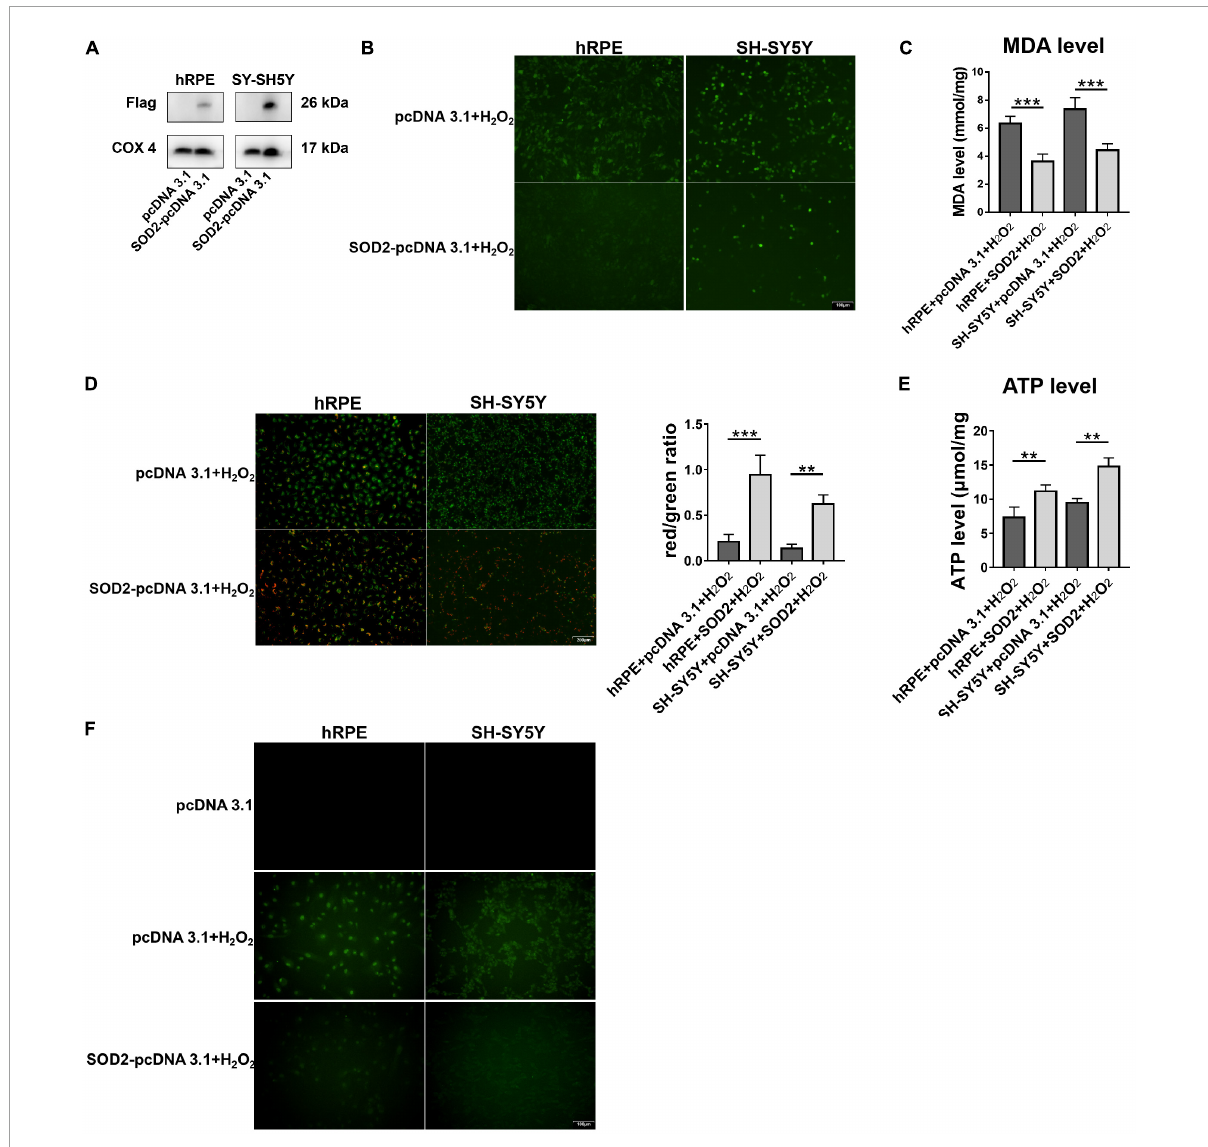
FIGURE5 Protective effects of SOD2 on hydrogen peroxide-induced oxidative stress, mitochondrial dysfunction and cell apoptosis in hRPE and SH-SY5Y. (A) The protein levels of exogenous SOD2 in mitochondria were detected by Western blot. The (B) ROS level and (C) MDA level in hRPE and SH-SY5Y were measured immediately after samples were prepared from each group. (D) Representative fluorescence intensity images and red/green ratio of JC-1 fluorescence from mitochondria in each group. (E) ATP level was detected in hRPE and SH-SY5Y cells. (F) TUNEL staining demonstrated cell apoptosis in hRPE and SH-SY5Y. The results (mean ± SD) were statistically significant (** p < 0.01, *** p < 0.001, n = 3–5) by using one-way ANOVA with Bonferroni correction, and the assays were performed three